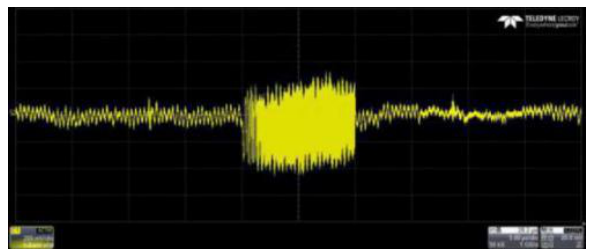
Figure 4 . The output RF signal of the balance detector. Figure 4. The output RF signal of the balance detector.